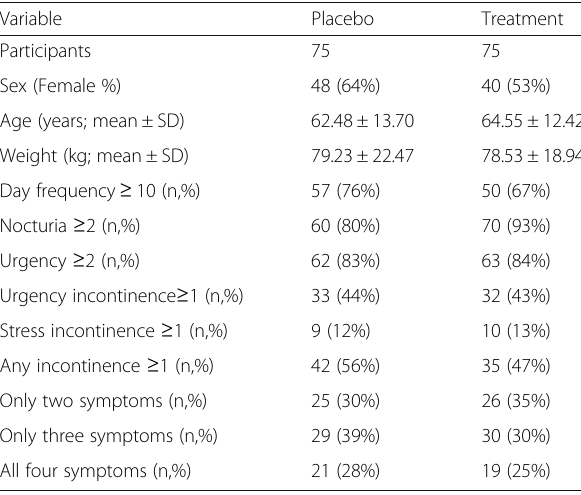
Table 1 Demographic and symptom characteristics of